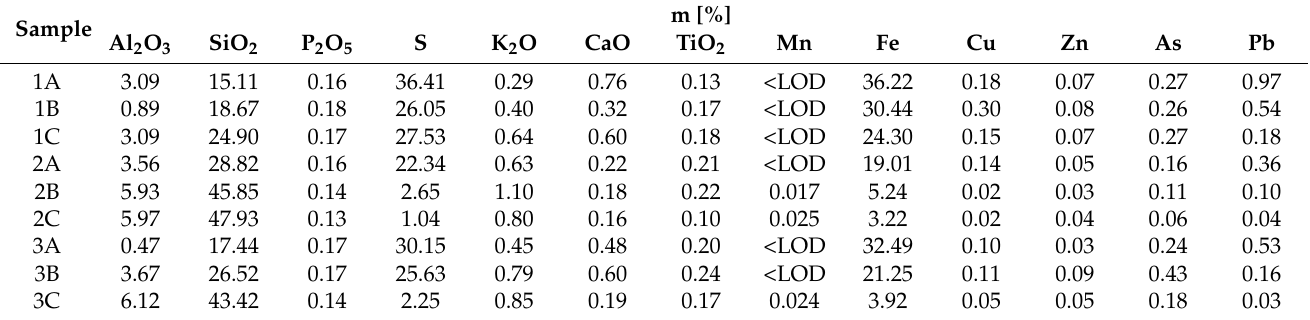
Table 1. Chemical compositions of samples from the B ă iut measurements.